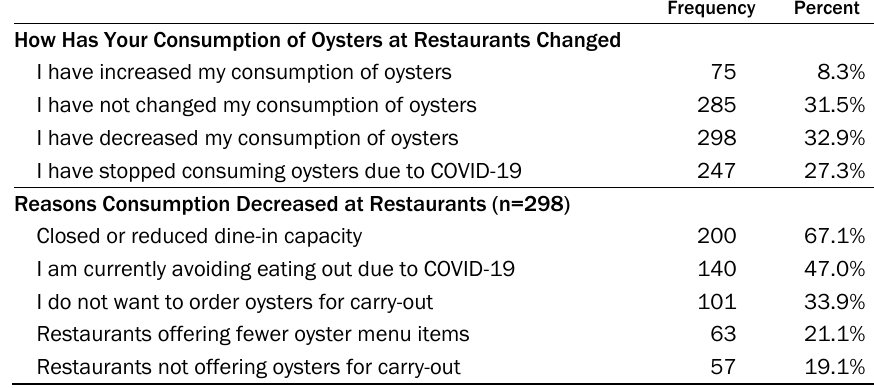
Table 2. COVID-19 Restaurant Impacts on Consumption ( n